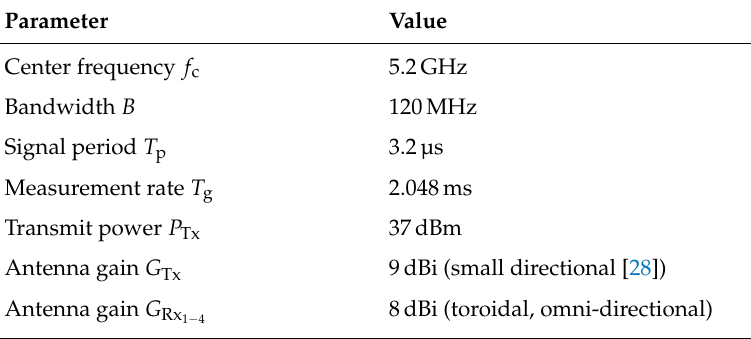
Table 1. Measurement